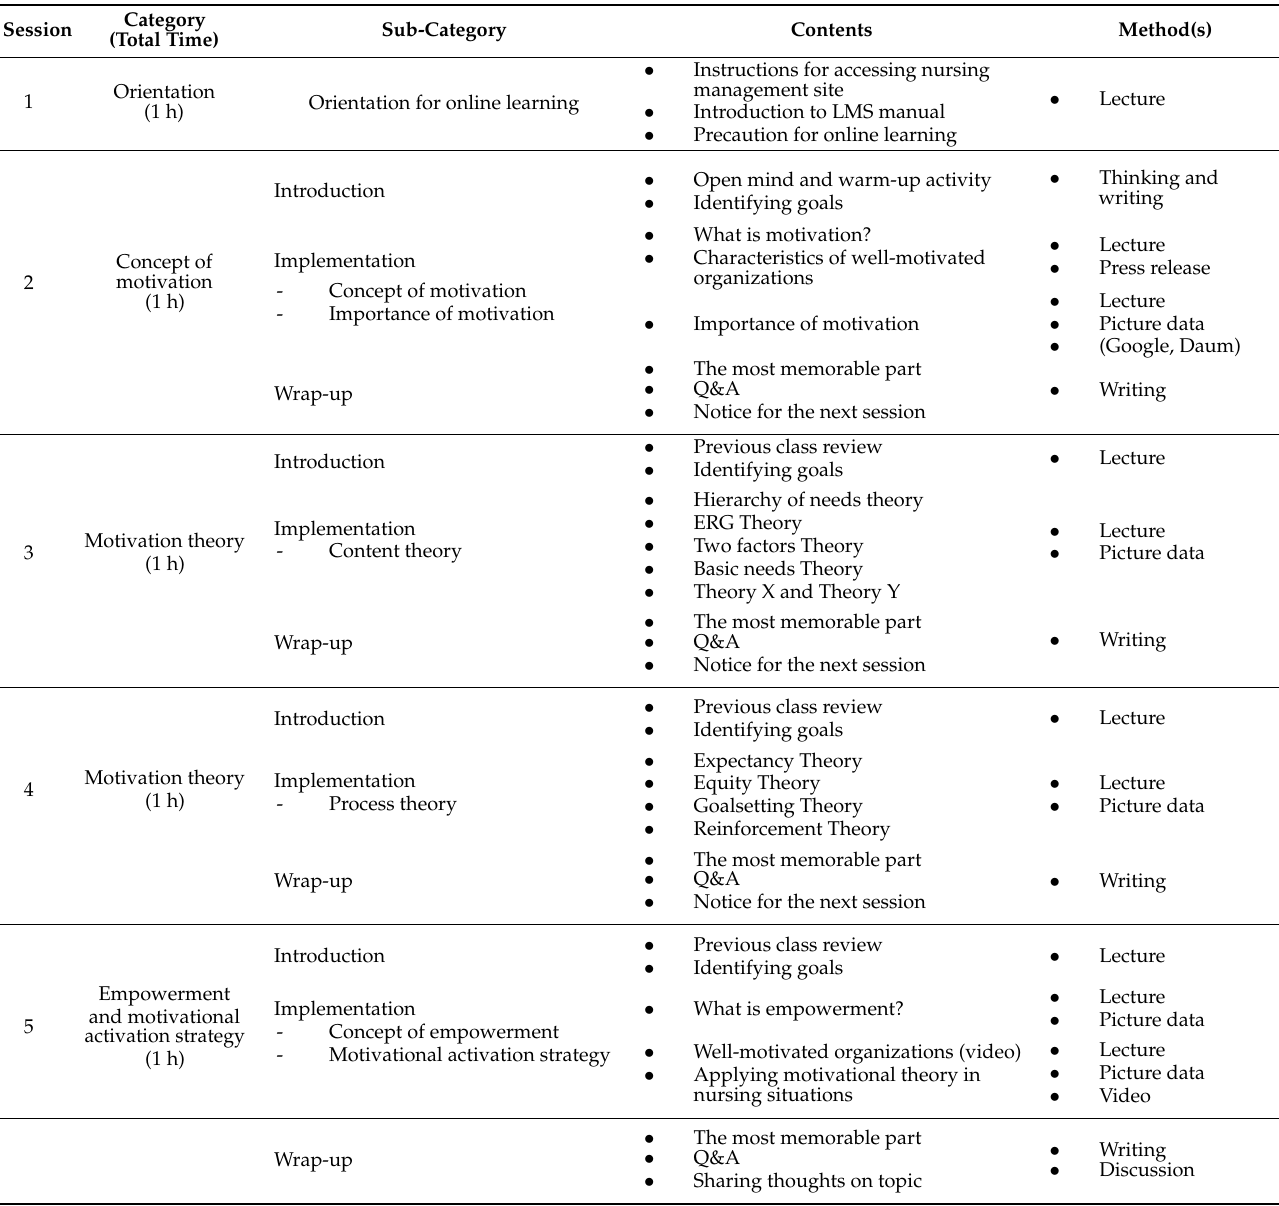
Table 1. Contents of the Group the Educational